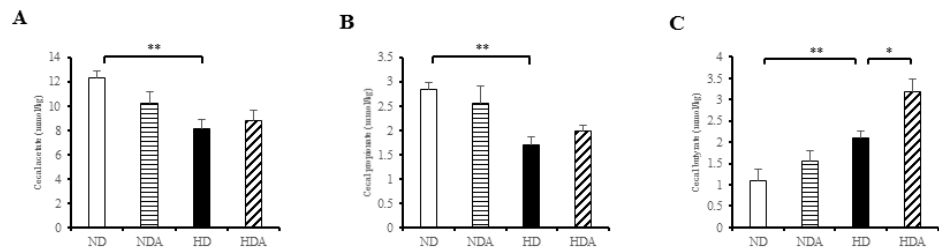
Figure 6. Concentrations of short-chain fatty acids (SCFAs) from cecal contents. ( A ) Acetate concentration, ( B ) propionate concentration, ( C ) butyrate concentration. SCFAs were measured by gas chromatograph. Result are shown as mean ± SEM ( n = 4). Significant di ff erences are indicated as * p < 0.05, ** p <